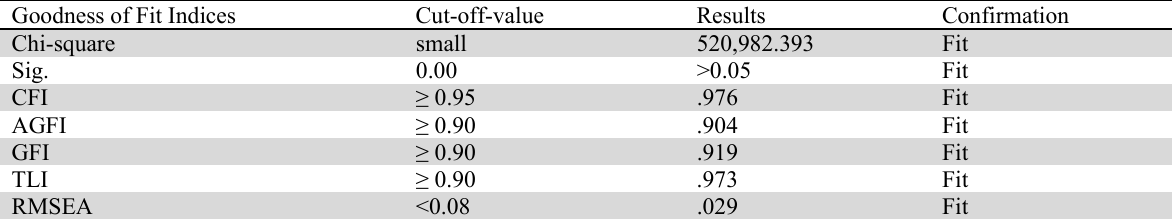
Goodness of Fit Goodness of Fit Indices Cut-off-value Results Confirmation Chi-square small 520,982.393 Fit